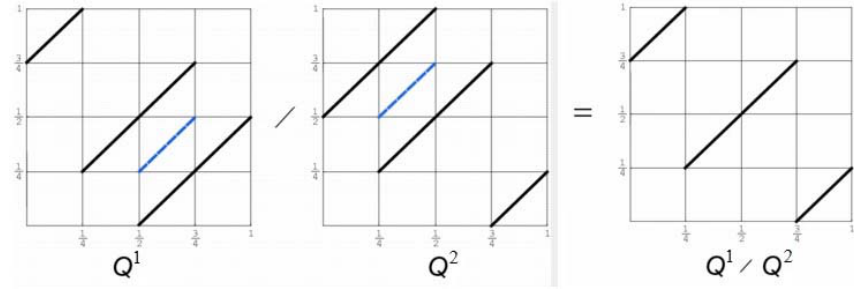
Figure 3: Example for which the diagonal splice of two proper-quasi-copulas is a